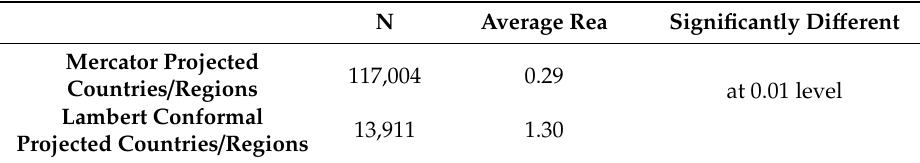
Table 6. Average relative estimated accuracy (rea) values for countries / regions projected with Mercator or Lambert map